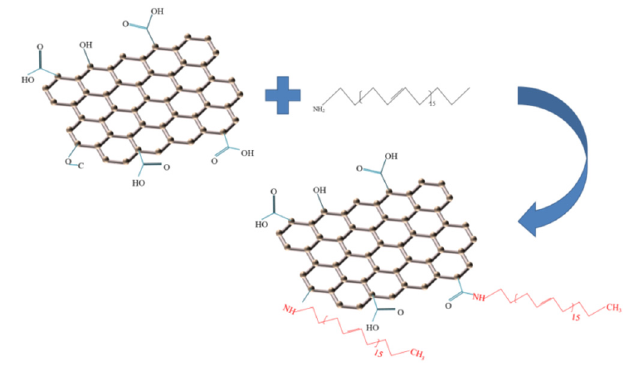
Figure 1. Modification mechanism of GA.